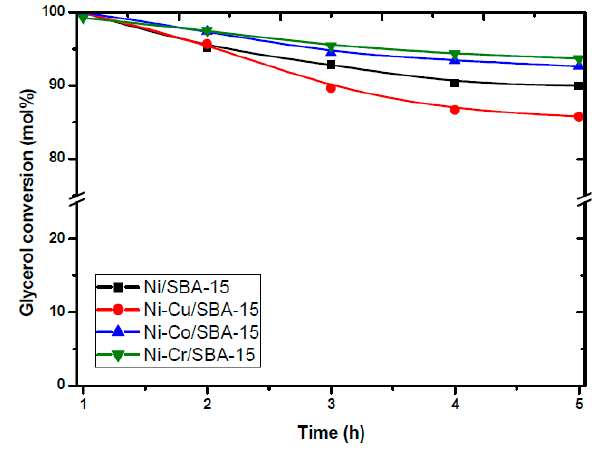
Figure 20. Conversion of glycerol over the Ni-(Cu,Co,Cr)/SBA-15 catalysts (T = 600 °C, P = 1 bar, WHSV glycerol = 7.7 h − 1 , water/glycerol = 6 mol/mol) [231].